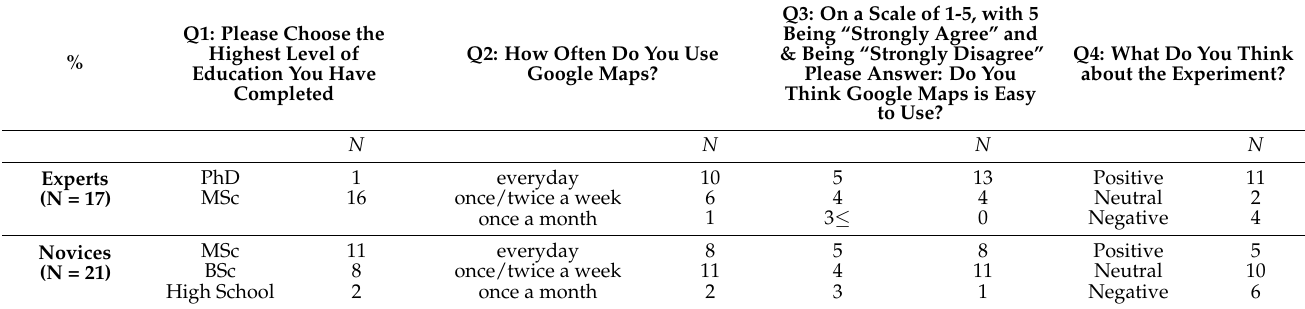
Table A1. User characteristics of the recruited participants [48] .